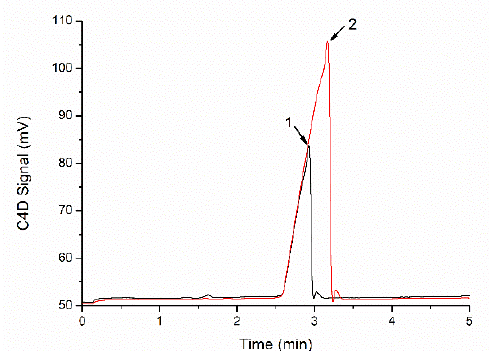
Figure 7. Electropherograms of phosphate in a soil extract sample before (1, black line) and after (2, red line) the addition of high-concentration ion standard solution.